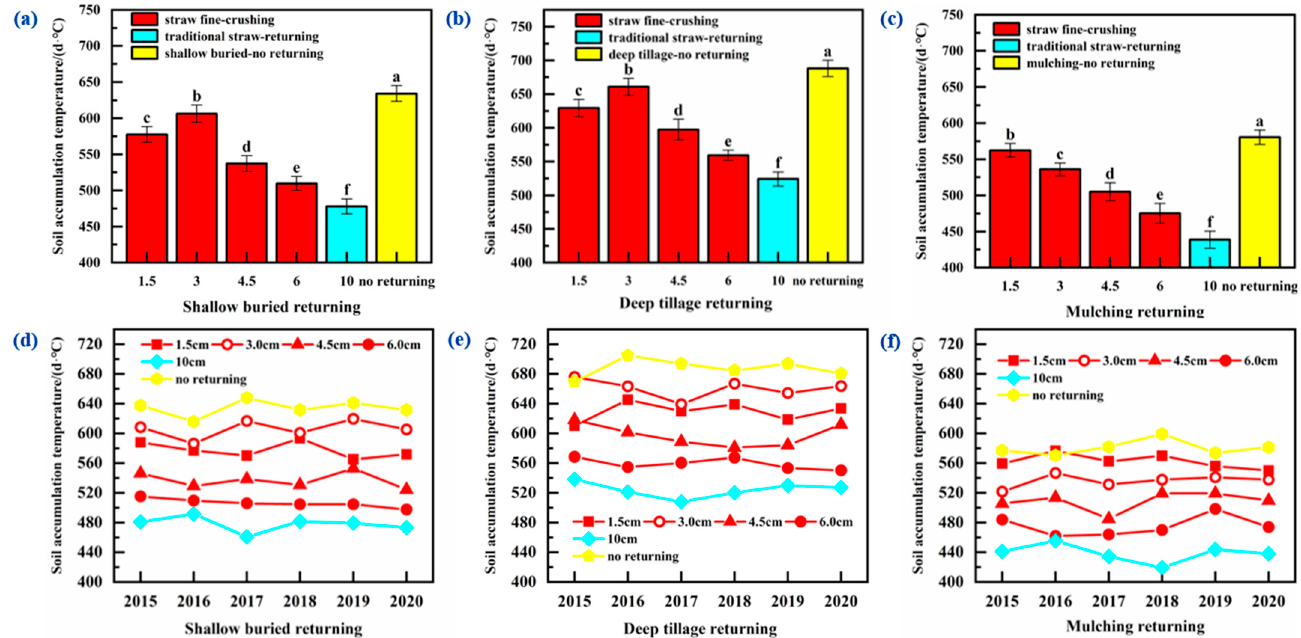
Figure 5. Six-year average of SAT shown in ( a – c ) and SAT values for each year shown in ( d – f ). Averages followed by different lowercase letters are significantly different according to LSD’s multiple-range experiment at the significance level of 0.05. Error bars are standard deviation.